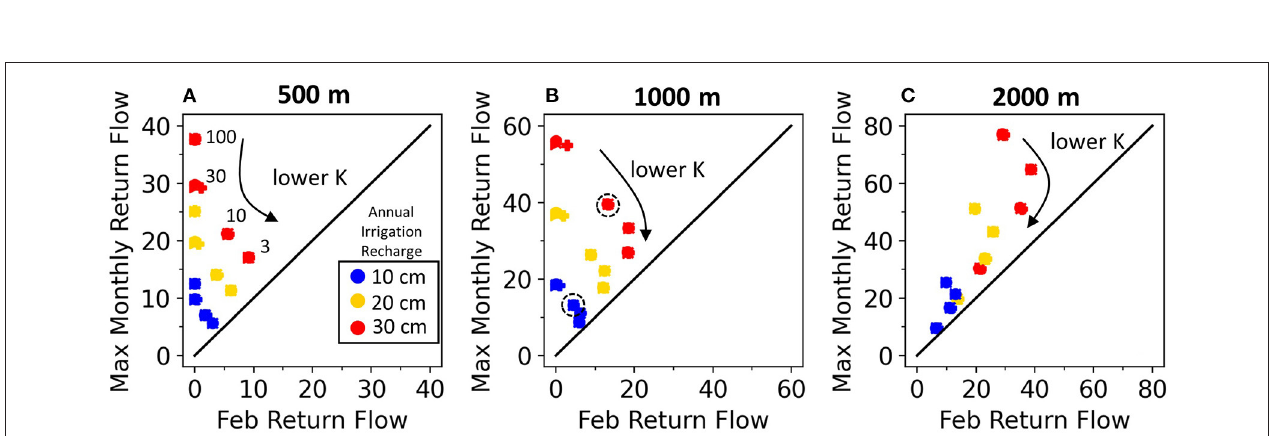
FIGURE 10 | Ratio of maximum monthly return flow to February return flow (representative of the long-term baseflow component). Individual values are organized by color (annual irrigation recharge), hydraulic conductivity (annotated for each graph) and by aquifer width (A–C) .